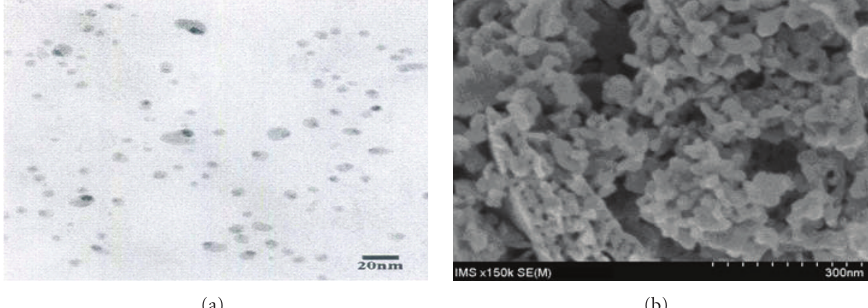
Figure 7: TEM (a) and SEM (b) micrographs of LaFeO 3 prepared by sol-gel method, followed by calcining process at 700 ◦ C.